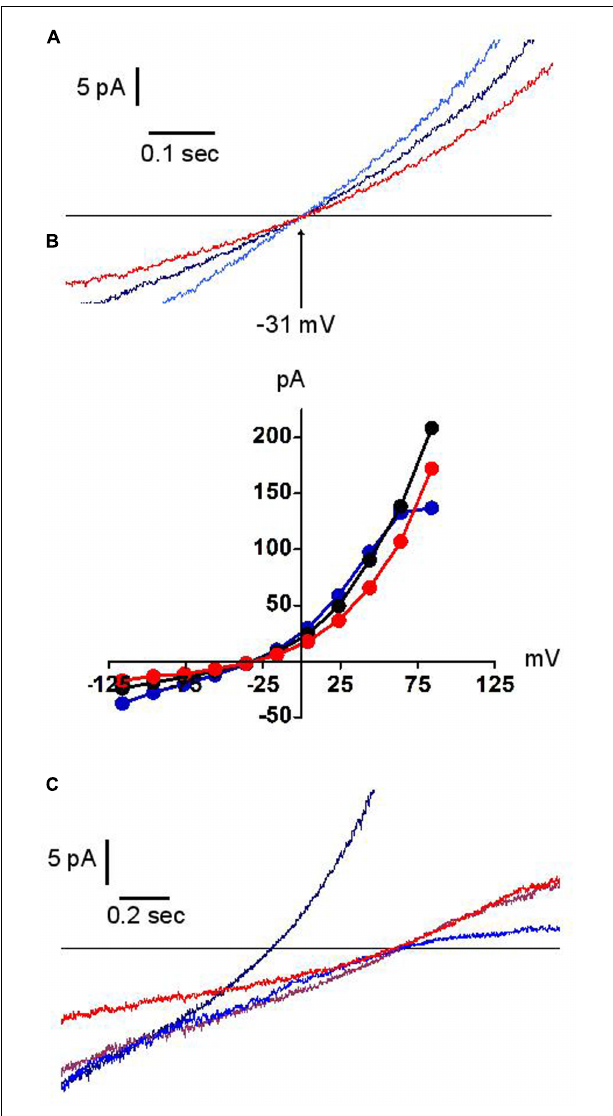
FIGURE 6 | Effects of external pH on the dialysis activated Cl – current in HVCN1 – / – neutrophils ( n = 3). Typical examples ( n = 3). Black traces pH 7.3, blue traces pH 5.7, red traces pH 9.0. Experiments were carried out in solution set E ( Table 1 ). (A) The reversal potential (–31 mV) is insensitive to pH. (B) Full IVs: pH has only minor effects on the current amplitude. (C) In low Cl – concentration solution (10 mM), outward rectification is seen at high pH (red trace), inward rectification at low pH (blue trace). The brown trace represents pH 7.3, 10mM Cl – solution. The black trace represents pH 7.3 at normal Cl –